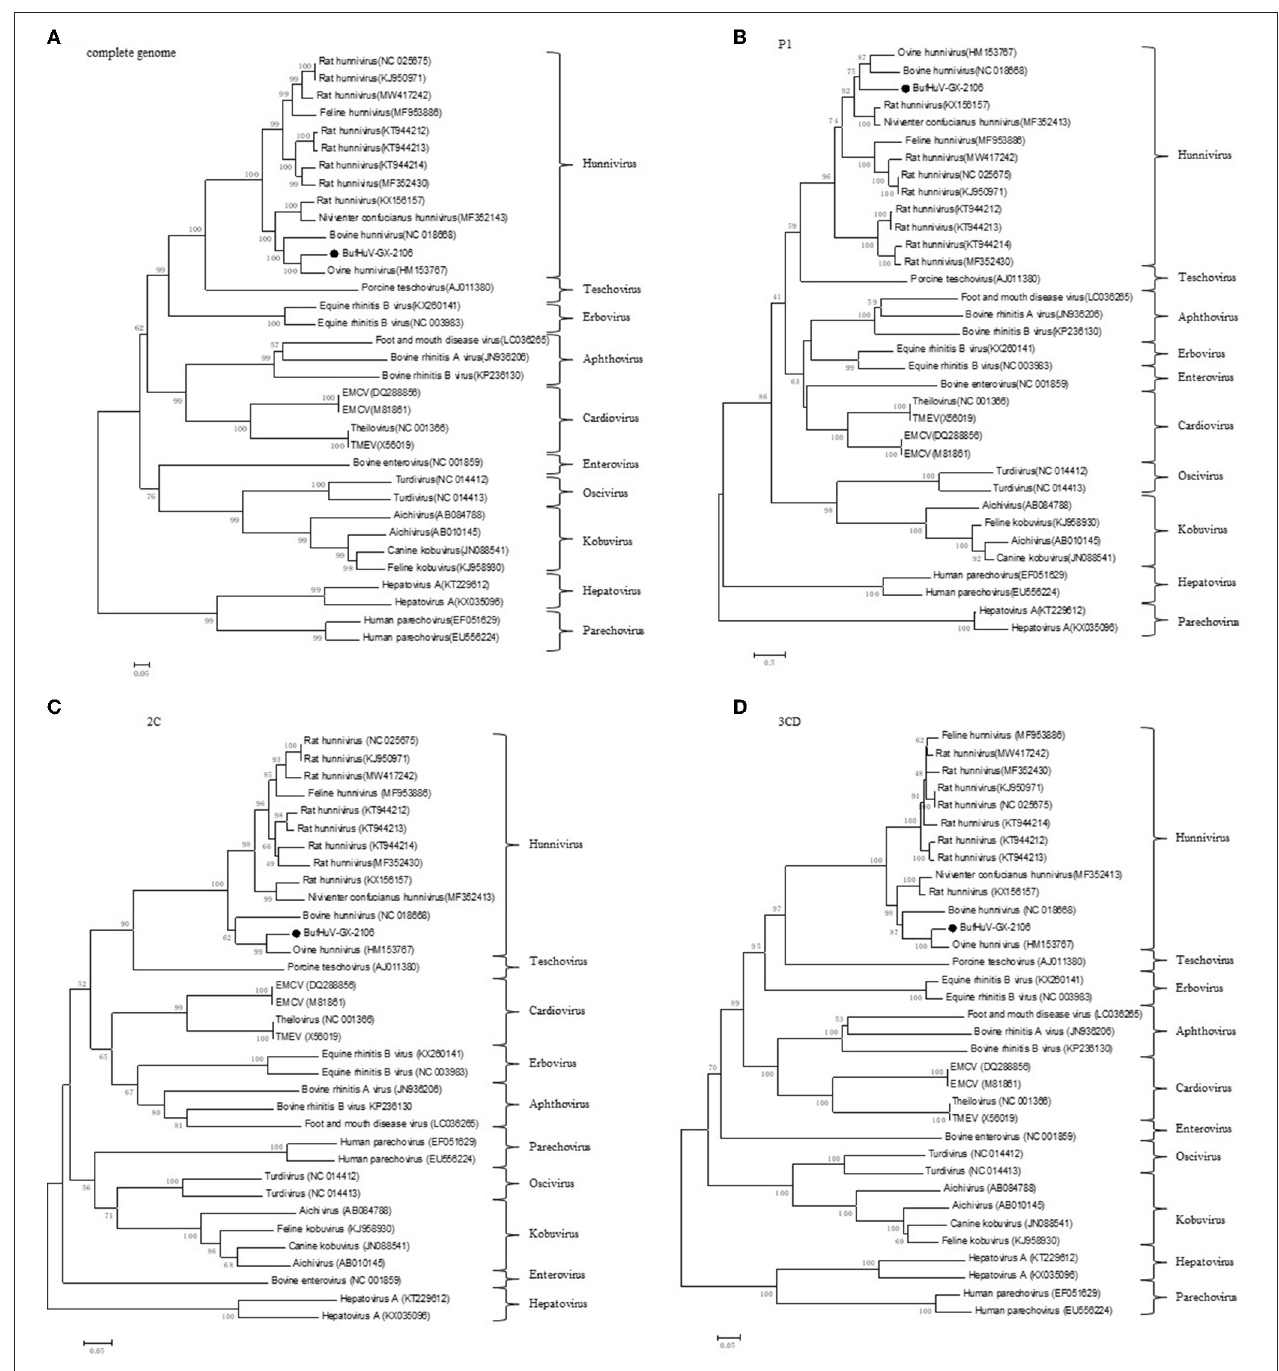
FIGURE 3 | Phylogenetic analysis of BufHuV-GX-2106 with representative picornaviruses. Phylogenetic tree based on the complete genome sequence (A) , complete amino acid sequence of coding regions of P1 (B) , 2C (C) and 3CD (D) of BufHuV-GX-2106 and representative picornaviruses. The phylogenetic trees were generated using the neighbor-joining method implemented in the program MEGA5.0. Bootstrap values are expressed as a percentage based on 1,000 replications. The strain obtained in this study is indicated by the black